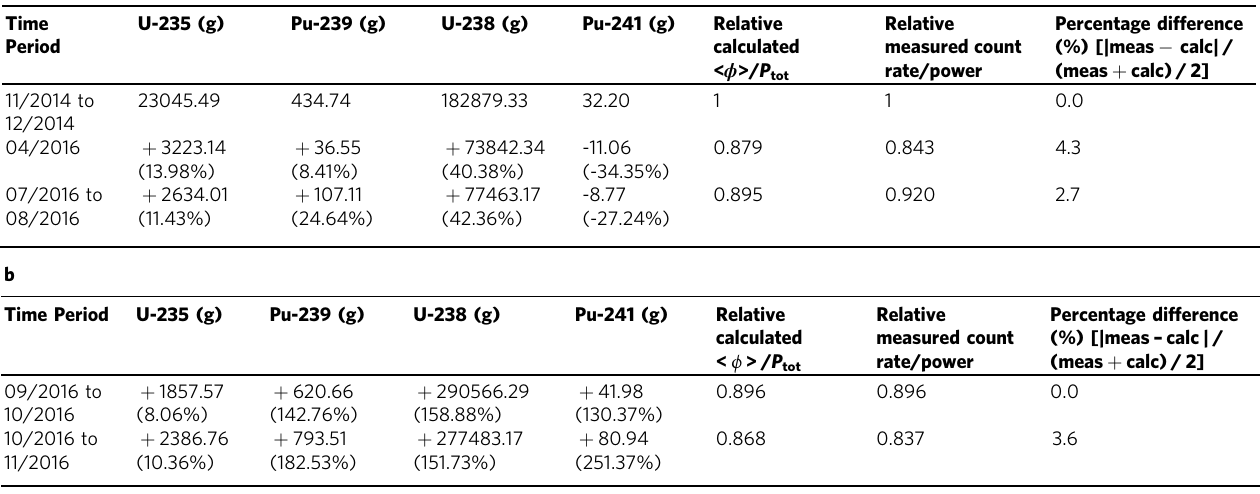
Table 3 Average masses of fi ssile isotopes for the time periods indicated in Fig. 2a,